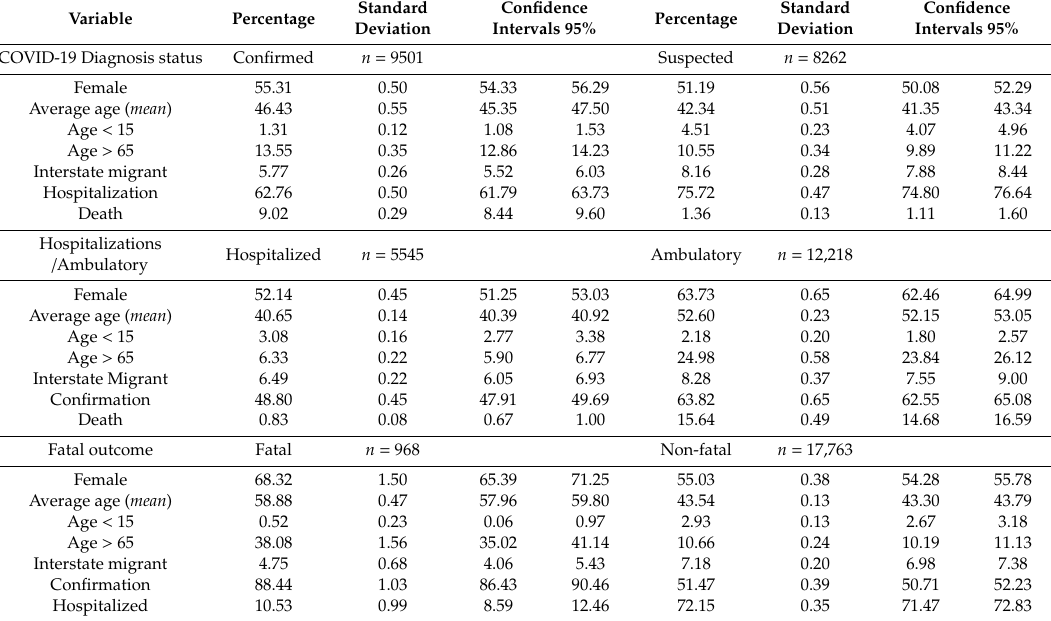
Table 3. COVID-19 cases by laboratory confirmation status, hospitalization, and mortality in Mexico between 28 February and 21 April 2020 ( n = 17,763).